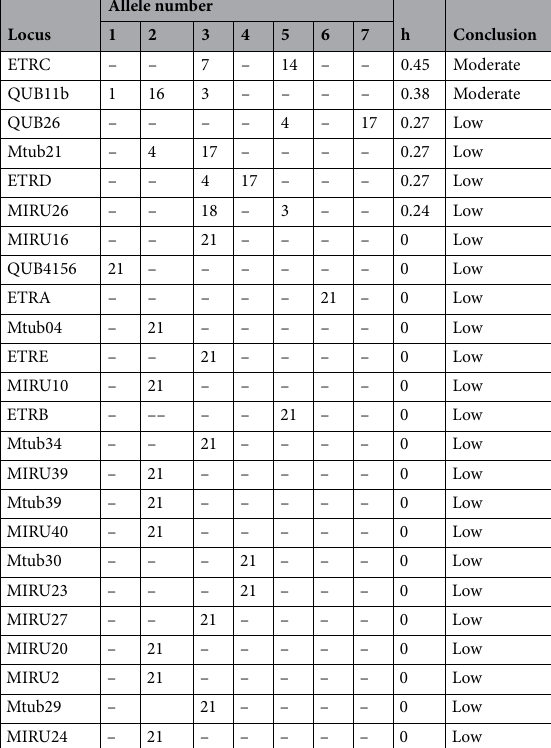
Table 2. Allelic diversity for each locus for Mycobacterium bovis